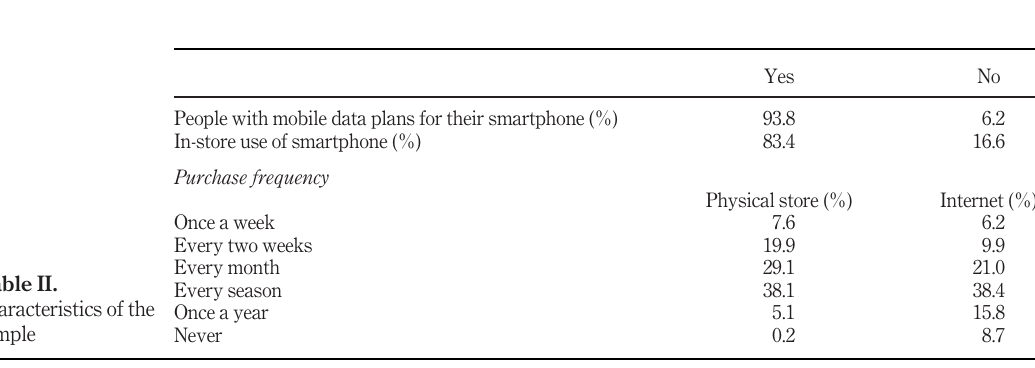
Table I. Items included on the